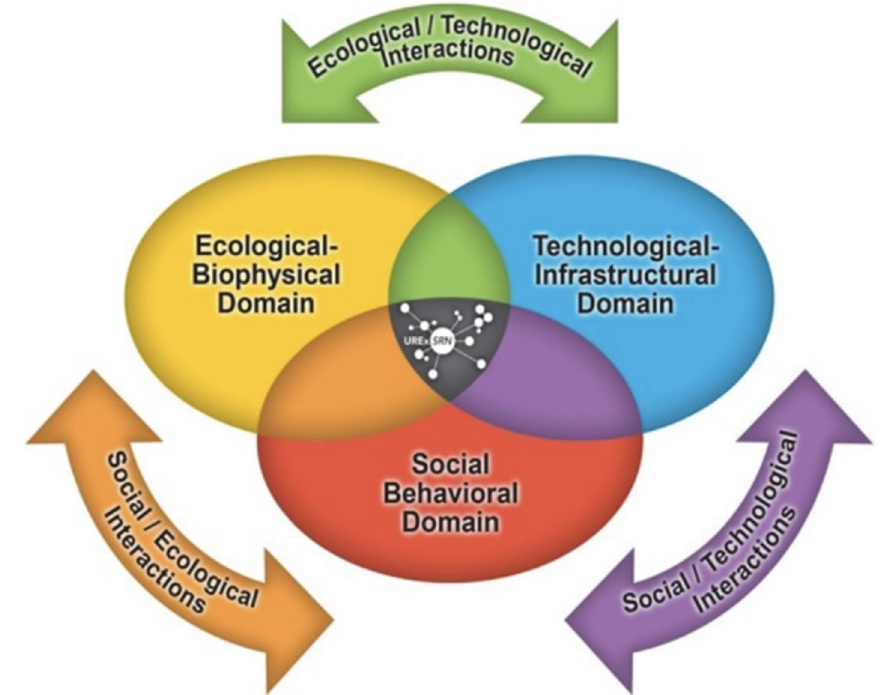
Fig. 1 Interactions Across Social-Ecological-Technological Systems